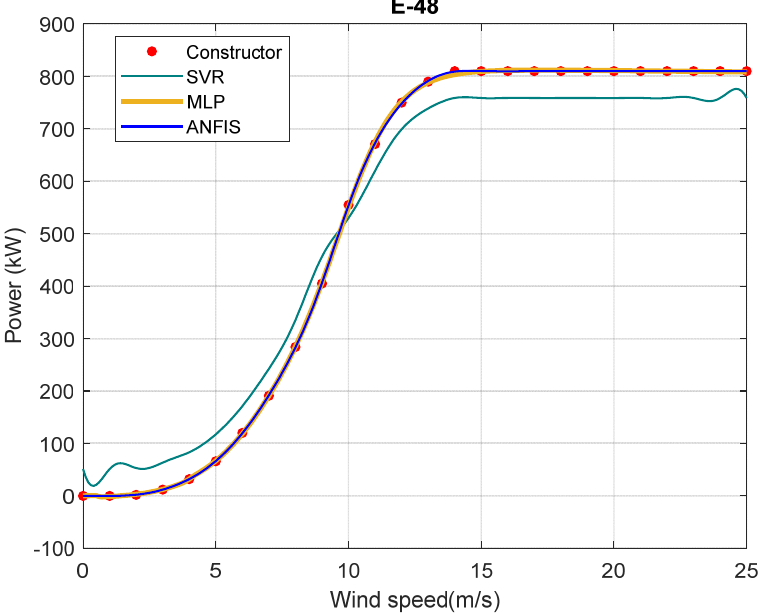
Figure 7. Characteristic power curve modeling for E-53.